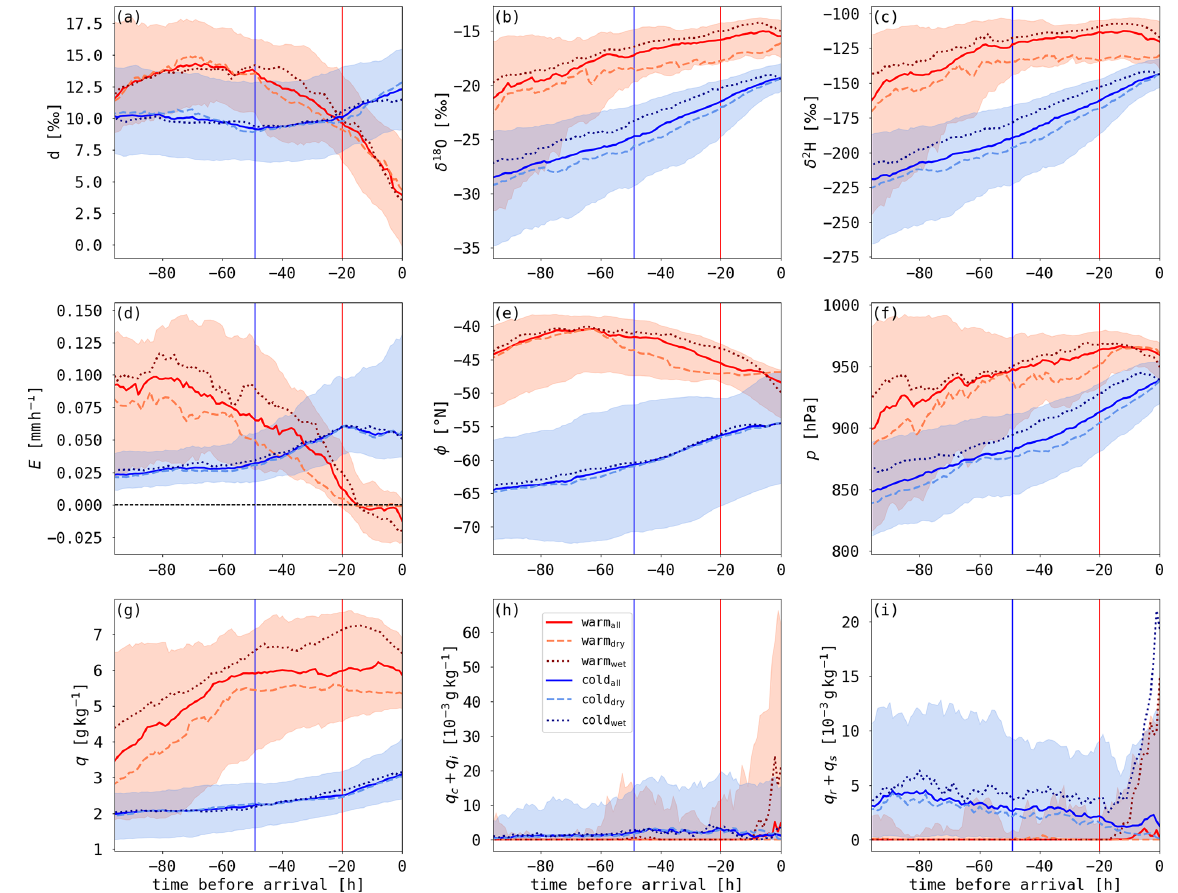
Figure 11. Composites of COSMO iso trajectories showing time series along trajectories from cold (blue) and warm (red) temperature advection events, respectively, of median values of (a) d , (b) δ 18 O, (c) δ 2 H, (d) surface evaporation ( E ), (e) latitude ( φ ), (f) pressure ( p ), (g) specific humidity ( q ), (h) the sum of cloud and ice water content ( q c + q i ), and (i) the sum of rain and snow water content ( q r + q s ). Cold and warm temperature advection events are only considered over open ocean (no sea ice, land fraction < 0 . 1 in COSMO iso ). Shadings denote the [25, 75] percentile range, and vertical lines show the median time step when the trajectories enter the cold (blue line) and the warm sector (red line). Furthermore, median values are shown for trajectories experiencing no surface precipitation upon arrival (total surface precipitation R tot < 0.01mmh − 1 ; dashed lines) and for those with surface precipitation upon arrival ( R tot > 0 . 01mmh − 1 ; dotted